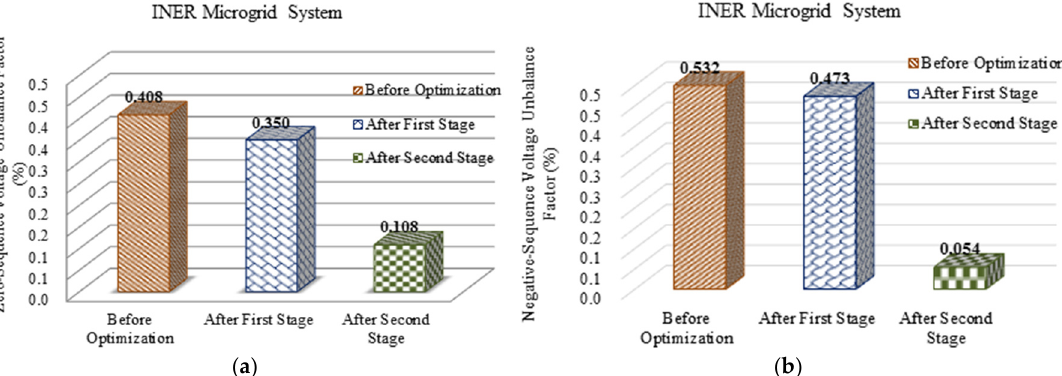
Figure 12. Simulation result of the Voltage Unbalance Factors of a weekday in summer of the INER microgrid: ( a ) zero-sequence voltage unbalance factor; ( b ) negative-sequence voltage unbalance factor.